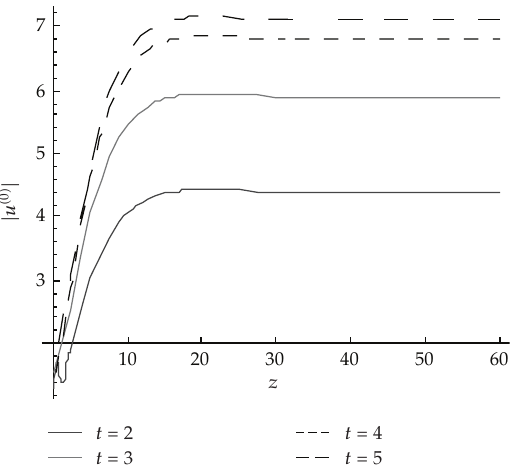
Figure 24: The zero-order approximation | u (cid:3) 0 (cid:4) | at α (cid:8) 1, T (cid:8) 10, γ (cid:8) 02 for di ff erent values of t , considering only one term in the series (cid:3) M (cid:8) 1 (cid:4) .